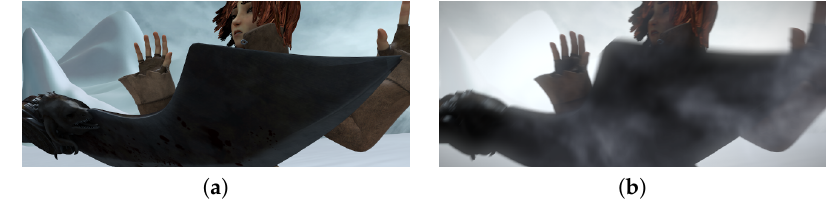
Figure 8. Image extracted from MPI-Sintel clean version and MPI-Sintel final version. We extracted frame_0014 from sequence ambush_2. ( a ) frame_0014 clean version. ( b ) frame_0014 final version.